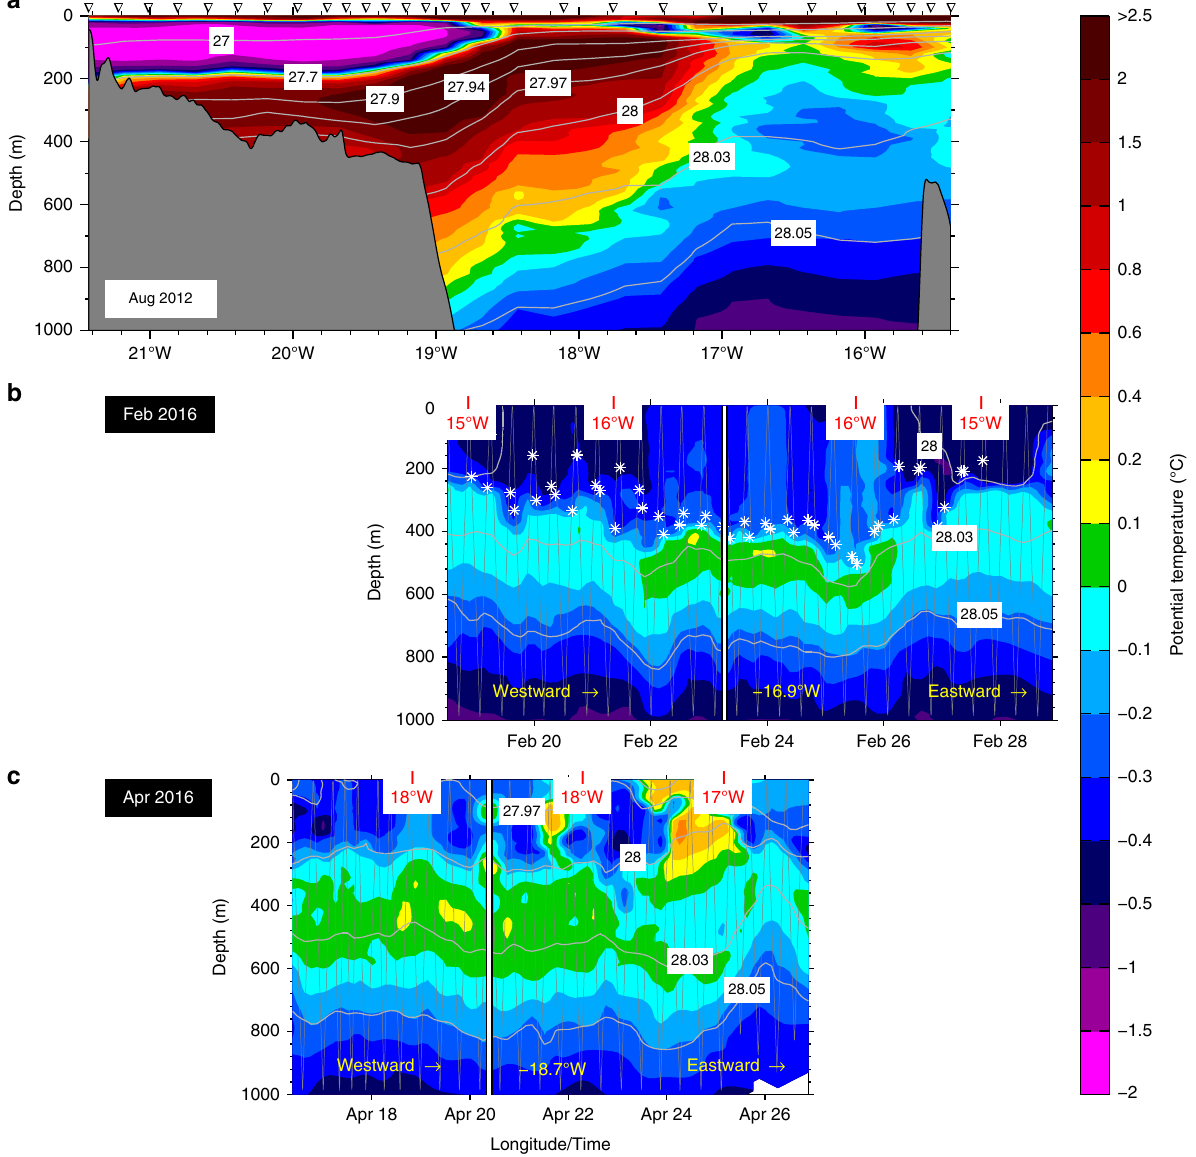
Fig. 2 Potential temperature transects off east Greenland. Vertical sections ( a – c ) from the shipboard and glider measurements indicated in Fig. 1. The gliders moved westward toward the ice edge, turned around at the longitude indicated by the white lines that are aligned with the shipboard transect, and then returned eastward along the same trajectory. The white crosses mark the depth of the mixed layer in the February 2016 glider transect ( b